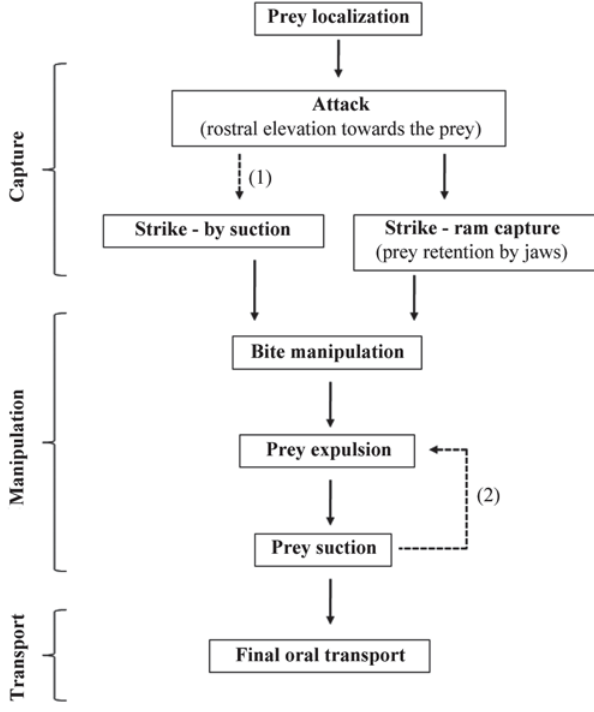
Fig. 5. Flow chart representing the feeding behavior of Potamotrygon motoro under captive conditions. After attack, prey capture by suction was observed (1) in one event; strike capture was used in a majority of the feeding events. During bite manipulation, a sequence of repeated expelling and suction events occurred (2) in four observed cases. This manipulation was followed by final oral transport, with the transport of the food item from the buccal cavity to the esophagus. Dashed arrow = an occasional alternative sequence. N = 13 observed